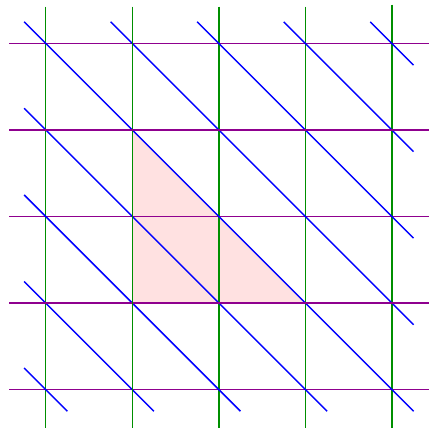
Figure 5 . Example of a disk instanton in 2d sigma-model associated with a genus-1 trisection of M 4 = C P 2 in (cid:12)gure 4. Shown here is a covering space of M ( F g ) on which each of the Heegaard branes B (cid:11) , B (cid:12) , B (cid:13) lifts to an in(cid:12)nite set of parallel straight